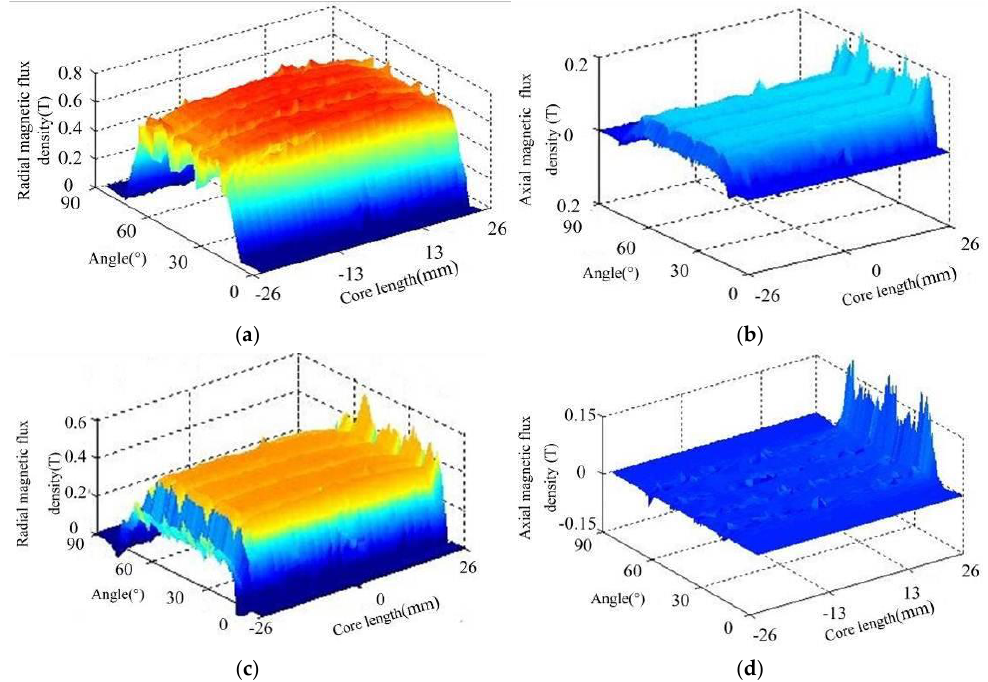
Figure 9. Distribution of air gap flux density with different CR axial displacement: ( a ) B δ r at Δ z = 1.5 mm, ( b ) B δ z Δ z = 1.5 mm, ( b ) B δ r at Δ z = 4 mm, ( c ) B δ z Δ z = 4 mm.